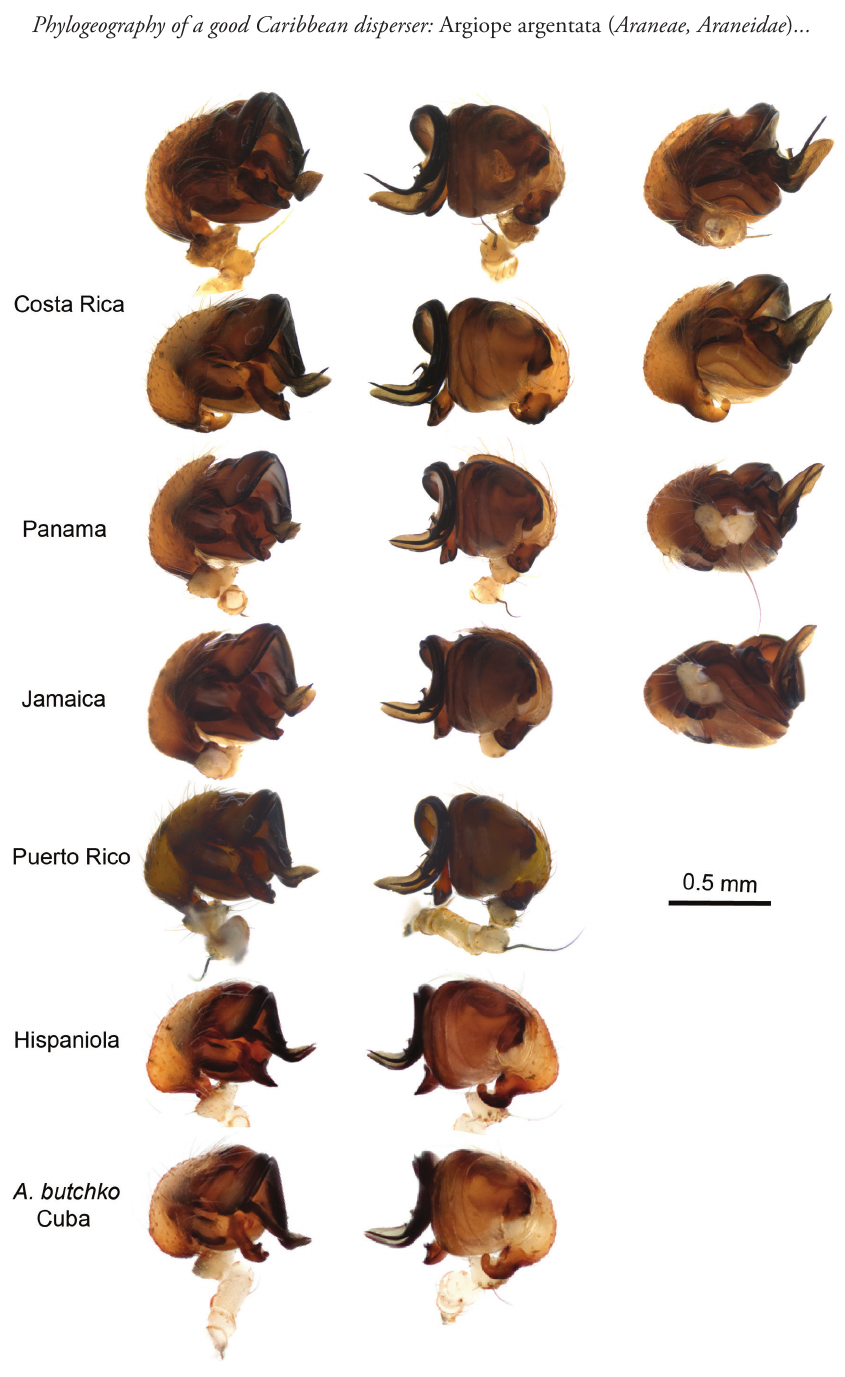
Figure 5. Comparative morphology of the male palpal organ of the widespread A. argentata and the new A. butchko . No clearly diagnostic features were identified in the new species, though slight differences in the terminal parts of the median apophysis and the embolus are observed and merit further comparative